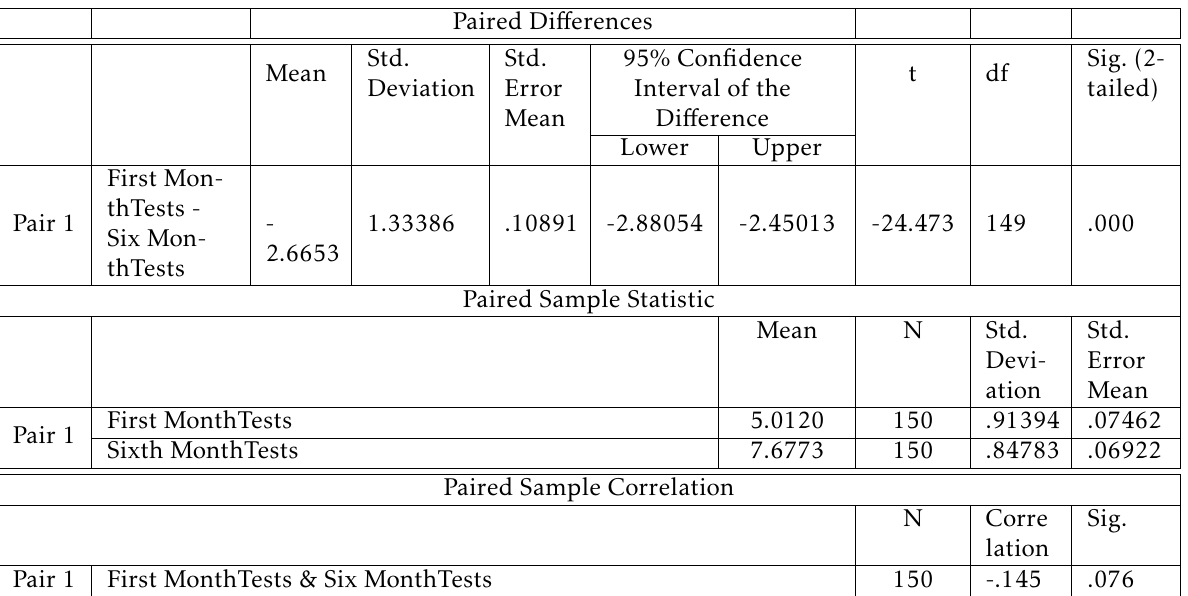
Table 4. Paired Samples Test of programming language learning mcq’s for first and sixth month